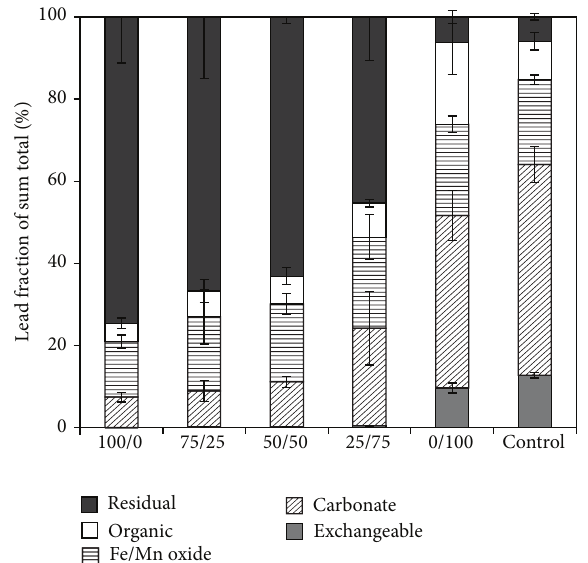
Figure 3: Sequential extraction of lead from soil amended with AMC of inorganic/organic = 100/0, 75/25, 50/50, 25/75, and 0/100 and without AMC (control) after 184 days of incubation. Vertical bars indicate the standard